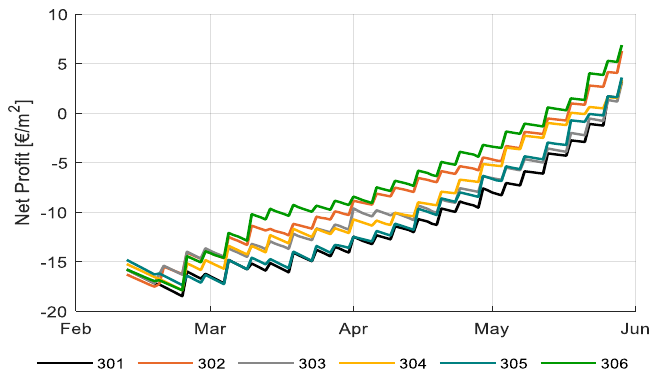
Figure A3. Cumulative income (€/m 2 ) in different greenhouse compartments (301-306) realized by different teams during the harvesting period (13 February until 29 May 2020).